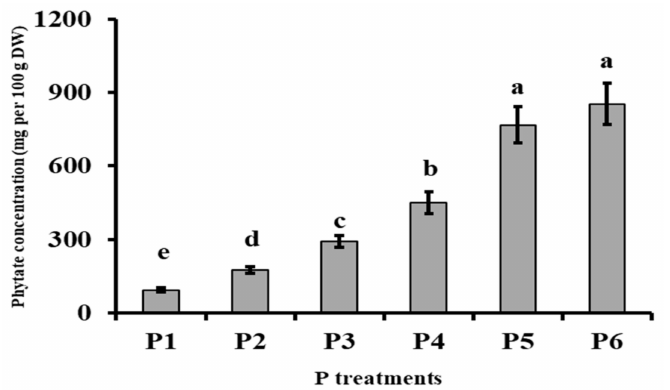
Figure 4. Effects of different P treatments on phytate concentration in seeds of green bean plants at the end of the experiment. Means with the same lower-case letter are not significantly different at p < 0.05 according to LSD and one-way ANOVA. Error bars represent standard deviation of the means (SE), n = 6.